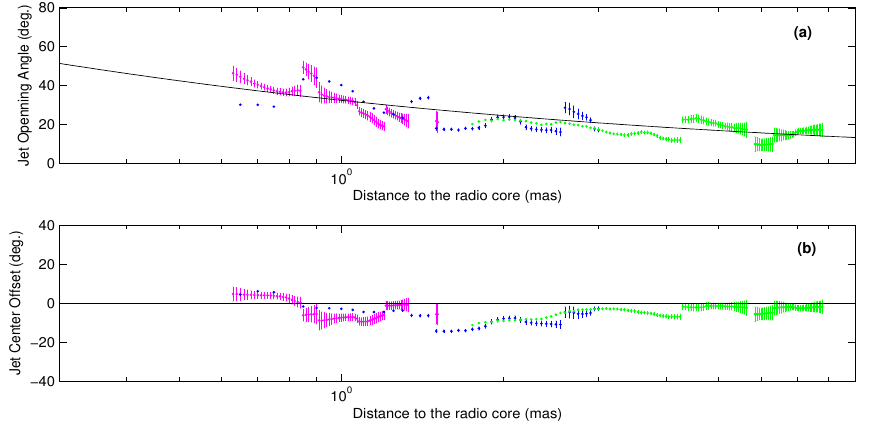
Figure 5. ( a ) The apparent opening angle ψ app as functions of core distance d . Parabolic collimation profile determined by Asada & Nakamura is shown for reference. ( b ) The jet center offset δ app as functions of core distance d . The jet axis is are shown for reference. The colors represent the measured frequencies: magenta for 86 GHz, blue for 43 GHz and green for 22 GHz. The uncertainties of ψ app and δ app are estimated (cid:113) ∆ PA 2 + ∆ PA 2 as . Only peaks with intensity above 5 σ are presented to make sure the result North South is